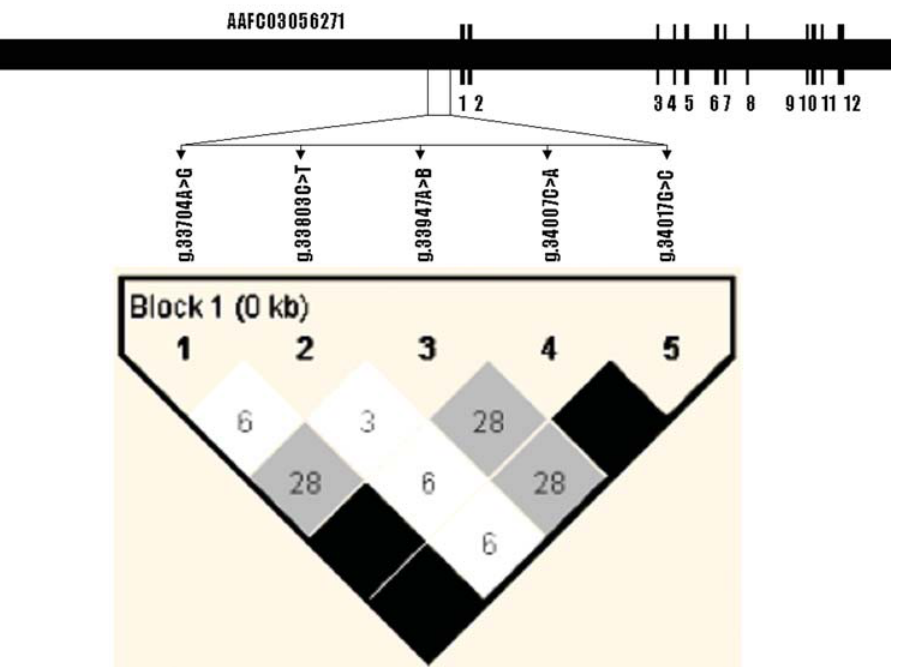
Figure 2. Genomic organization and haplotype analysis in the bovine CRHR2 gene. Coding exons are marked by black boxes. Pairwise linkage disequilibrium relationship for 5 mutations is illustrated based on r 2 measurements. The mutation g.2072A . B represents AAFC03056271.1: g.33947- 33964TGAATCCAGCCTGAGTTG . CTTTGTCTTGAG .